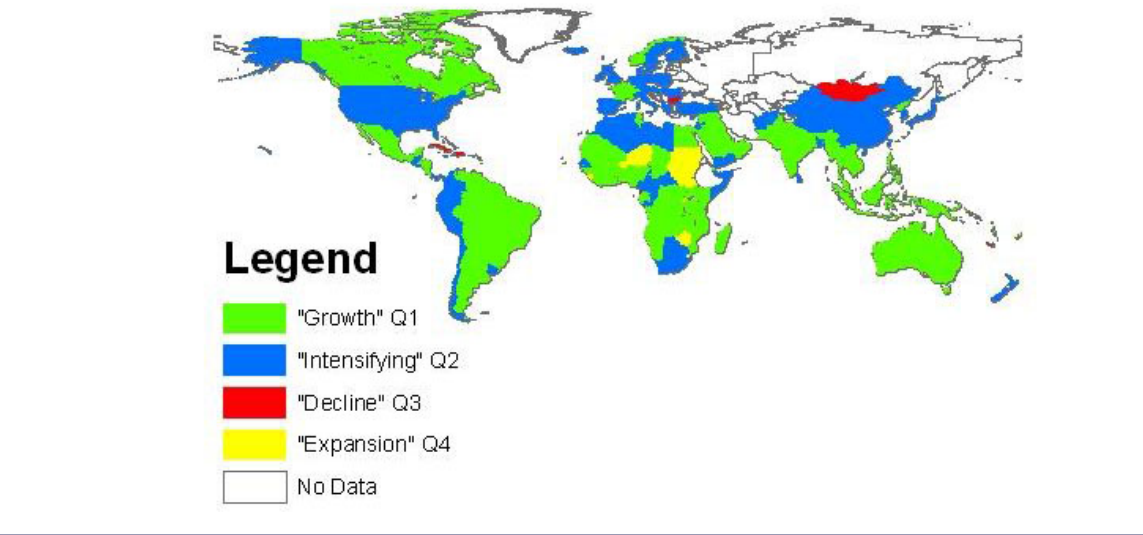
Fig. 2 . Geographical representation of the four groups of countries, depending on the signs of dY (log of relative change in yield at national level) and dA (log of relative change in cultivated area at national